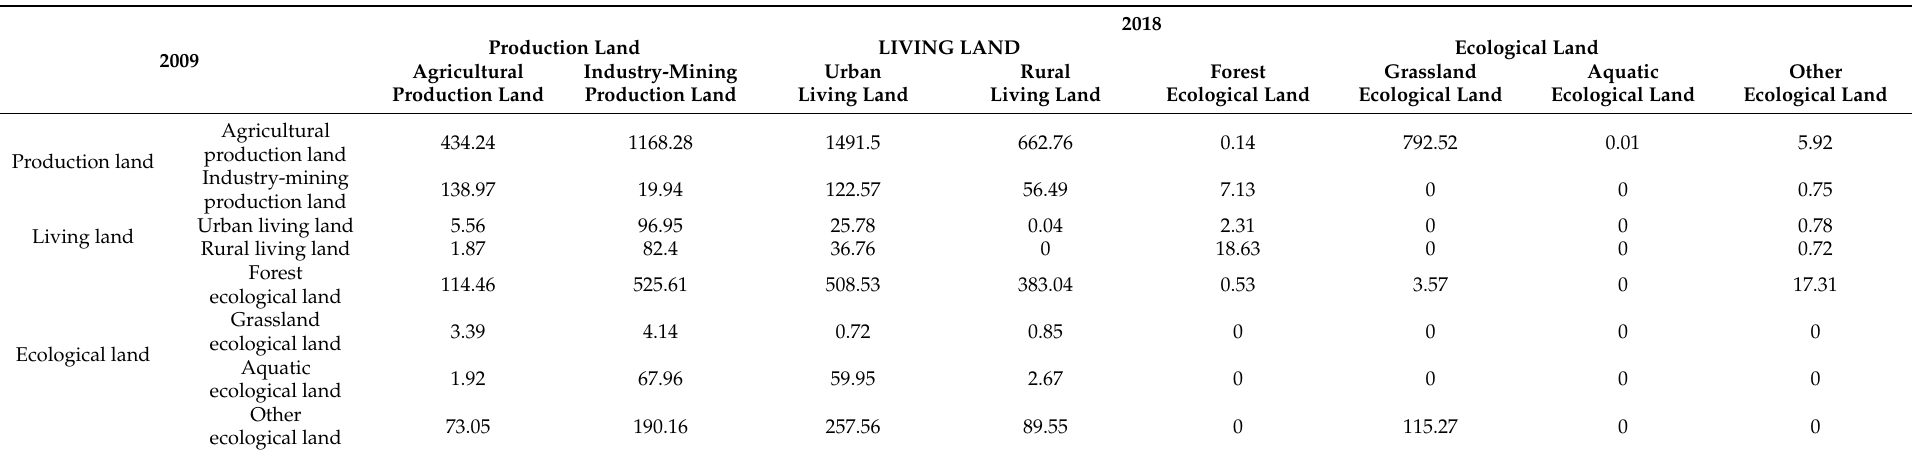
Table 4. The land use transfer matrix of the conversion of PLES in Haikou from 2009 to 2018 (unit: